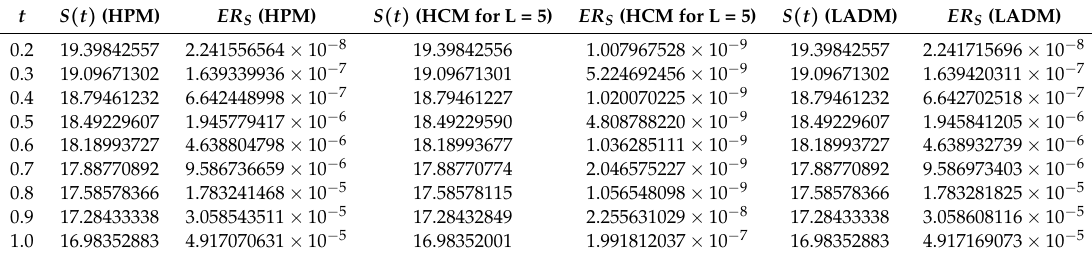
Table 1. The values of S ( t ) , and the residual errors ER S for HPM, HCM and LADM.